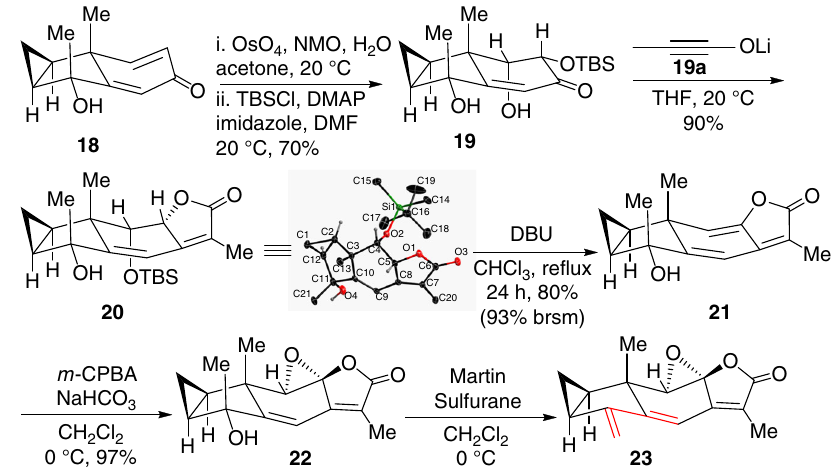
Fig. 5 Synthesis of diene 23 . NMO N -methylmorpholine N -oxide, TBS tert -butyldimethylsilyl, DMAP 4-dimethylaminopyridine, DBU 1,8-diazabicyclo[5.4.0] undec-7-ene, and m -CPBA meta -chloroperbenzoic